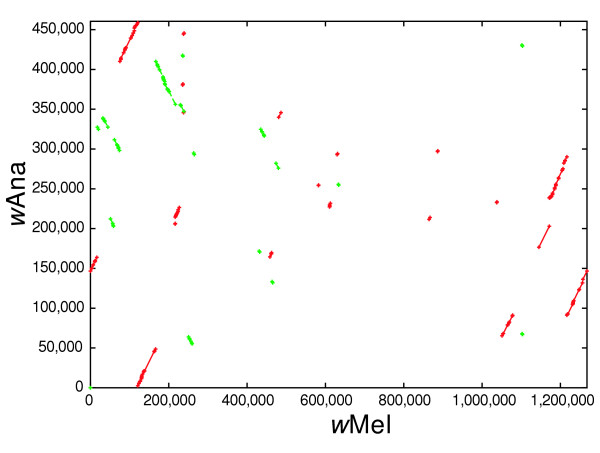
Alignment of complete wMel genome (horizontal axis) to longest scaffold from the wAna genome assembly. Red points indicate sequences aligned in the forward orientation, green points indicate reverse orientation. The diagonals represent colinear regions, and breaks in the diagonals correspond to inversions and translocations between the two genomes.